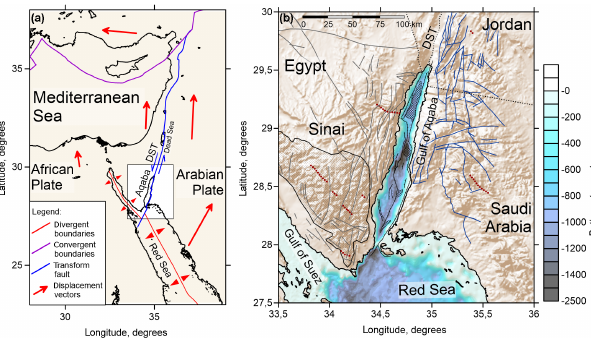
Figure 1. (a) Major tectonic framework of the study area schemati- cally representing the main displacements of the major plates. DST is the Dead Sea Transform fault. (b) Tectonic units in the area of the Gulf of Aqaba. Gray lines are faults in Egypt (Darwish and El Ababy, 1993; Bosworth and McClay, 2001), blue lines are faults in Saudi Arabia and red dotted lines are dykes according to Eyal et al.